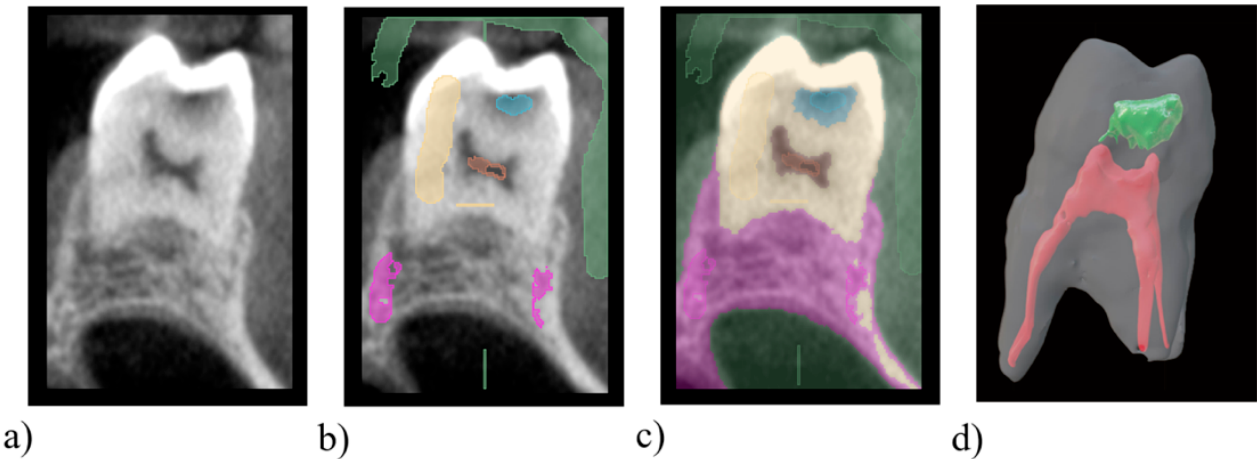
Figure 3. Conception of an educational model with carious process using a free software 3DSlicer. ( a ) 3D image from a cone beam computed tomography of a maxillary molar presenting a cavity. ( b ) Attribution of pixel labels for air (green), dentin (yellow), pulp (red), cavity (blue) and bone (purple) using the “paint” tool on the 3D image. ( c ) Segmentation of the 3D image using the “Grow from seeds” tool. ( d ) Export of the pulp, cavity and tooth STL models and visualization in the software Blender using transparent labels.